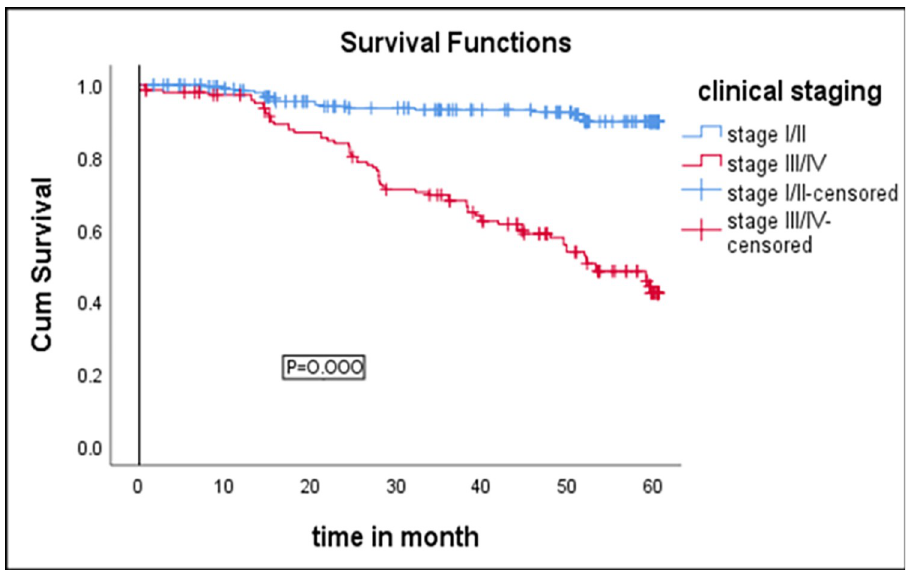
Fig 2. Kaplan-Meier survival curve of anemia -free survival proportion based on WHO clinical staging among adults on HIV care.